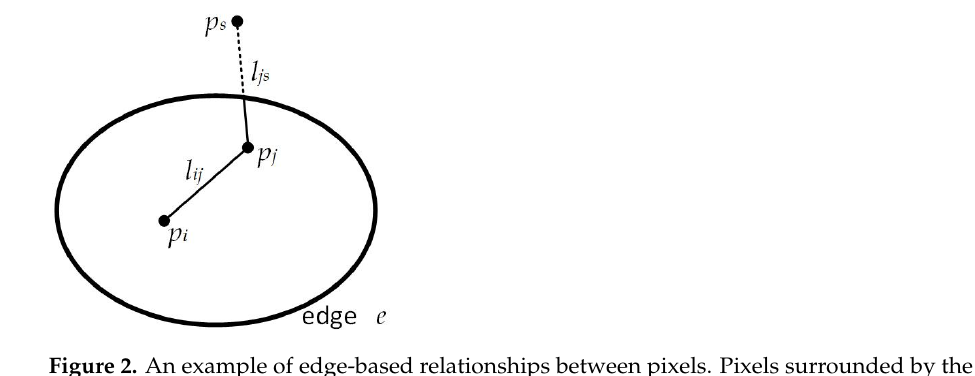
Figure 2. An example of edge-based relationships between pixels. Pixels surrounded by the same edge, such as p i and p j , are likely to be similar. Correspondingly, pixels separated by edges, such as p j and p s , are likely to belong to different homogeneous regions.